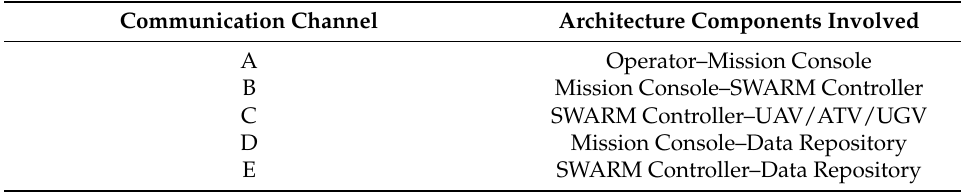
Table 1. Identification of communication channels in the architecture described in Figure